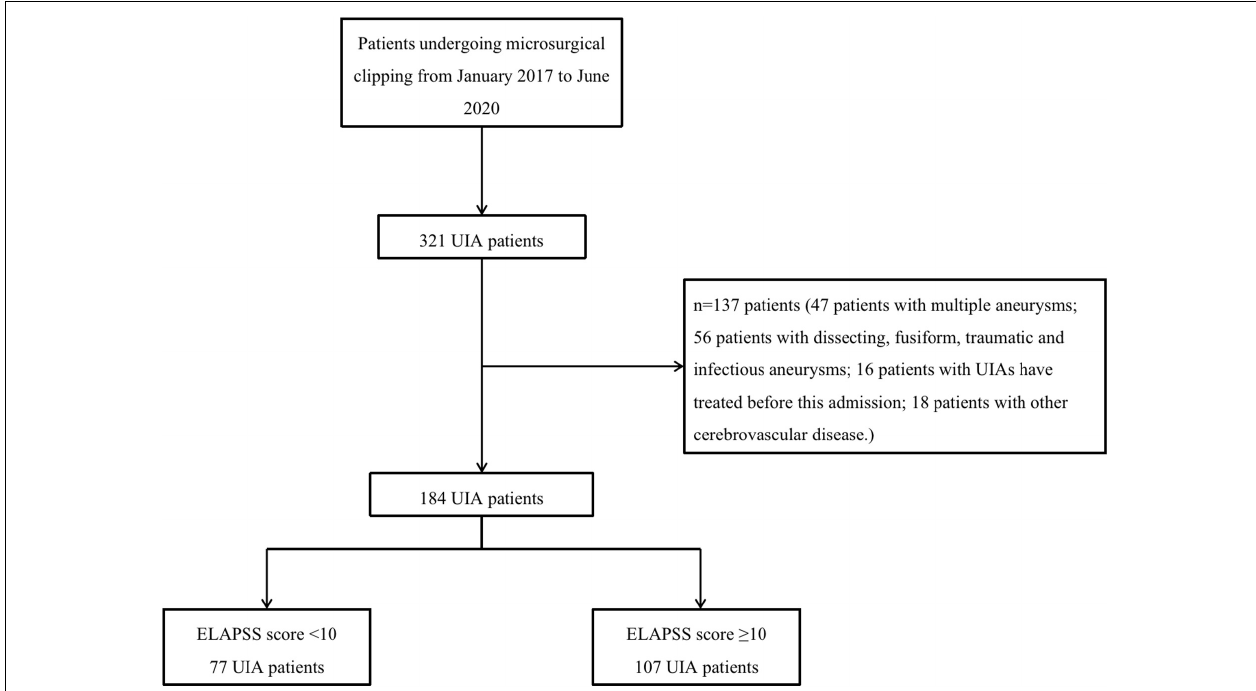
FIGURE 1 | The flow chart of patient enrollment. UIA, unruptured intracranial